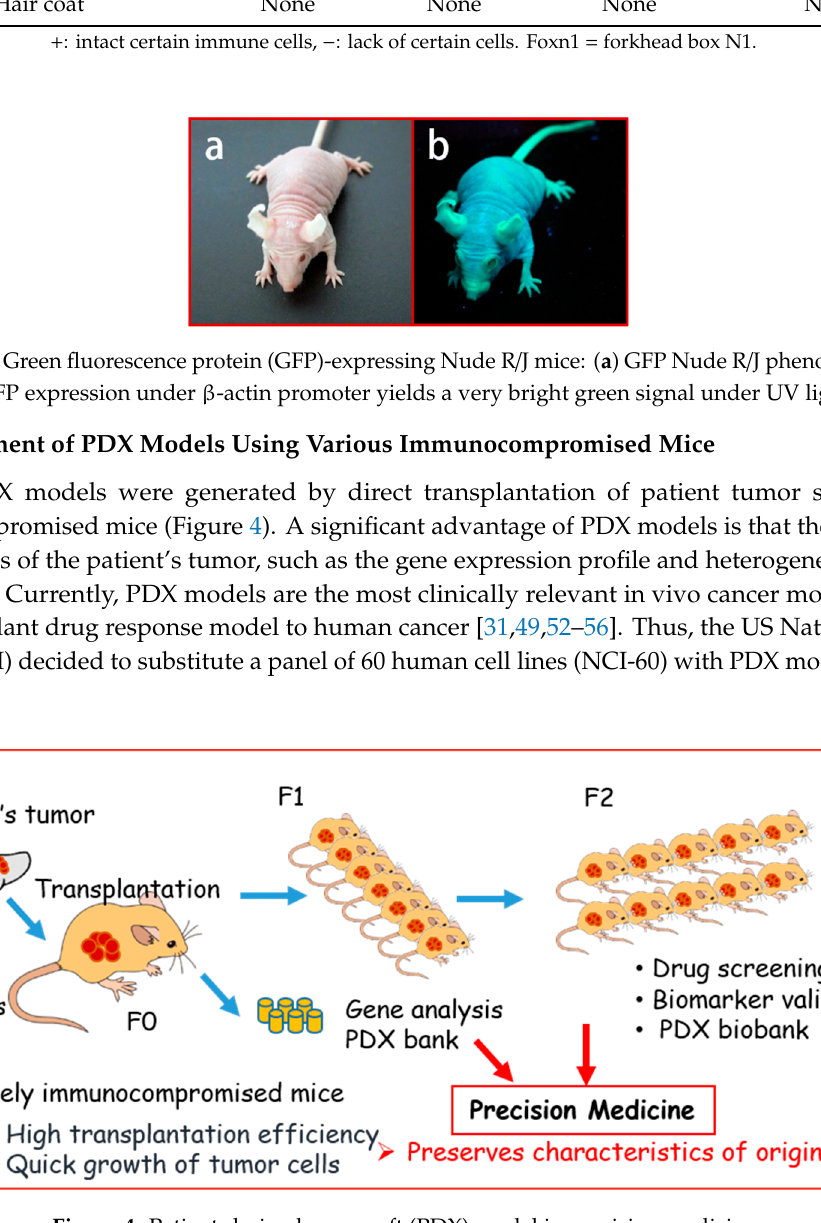
Figure 4. Patient ‐ derived xenograft (PDX) model in precision medicine. Figure 4. Patient-derived xenograft (PDX) model in precision